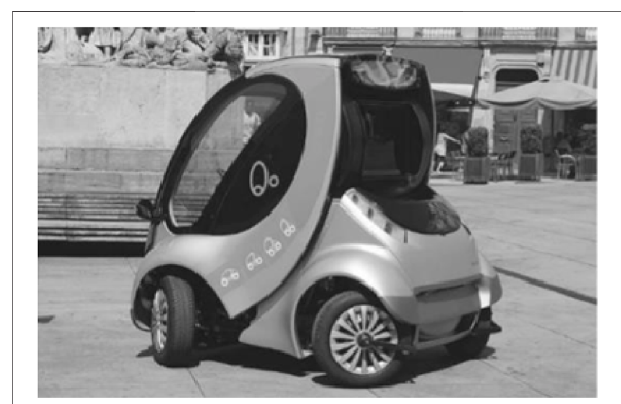
FIGURE 7 | Hiriko Fold — A vehicle employing in-wheel